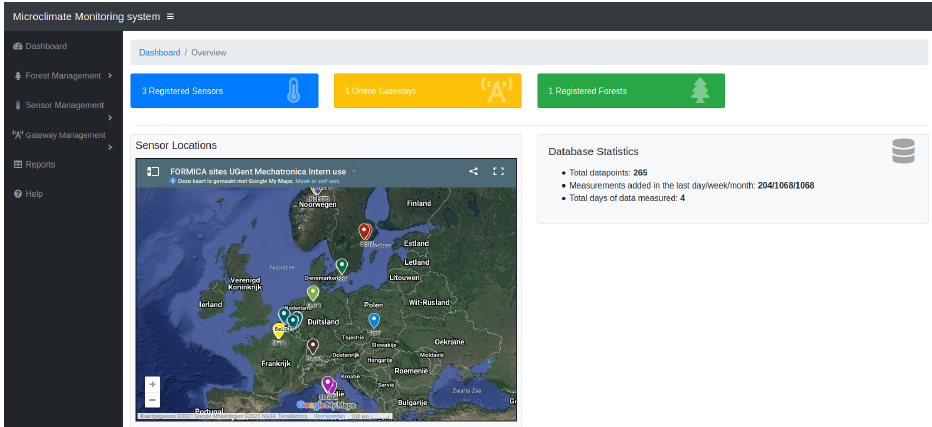
Figure 2. Sensor node in the experimental set-up, consisting of a sensor board (square block), radiation shield (white) and ground probe. This set-up is located in the “Aelmoeseneie” forest in Gontrode, Belgium (50.98° N, 3.80° E).